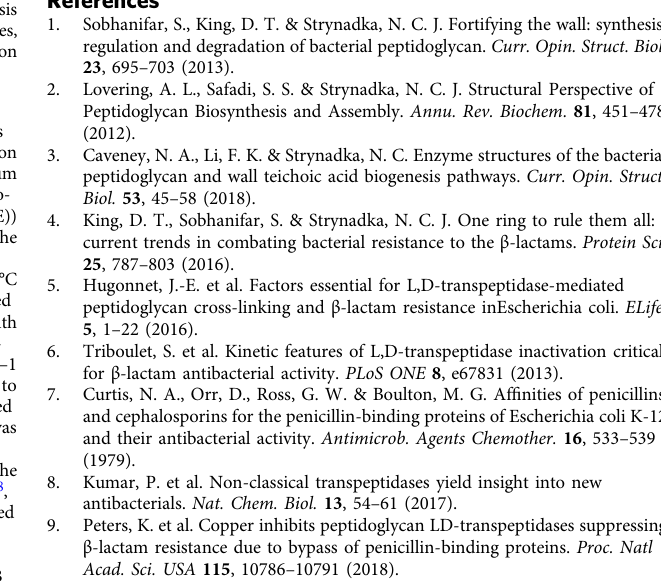
Molecular dynamics simulations . A complete model for the meropenem acyl and apoenzyme forms of YcbB for molecular dynamics simulations was built from our structure of YcbB-meropenem acyl-enzyme complex with missing disordered loop regions built in using ModLoop 36 . This was then solvated and simulation input